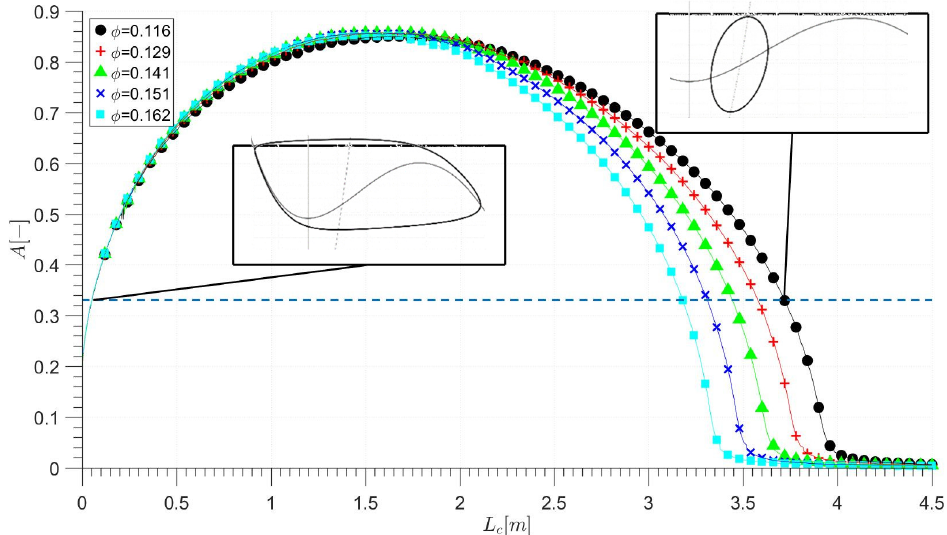
Figure 7. Pressure oscillations amplitude for different operational points and L c parameter value.